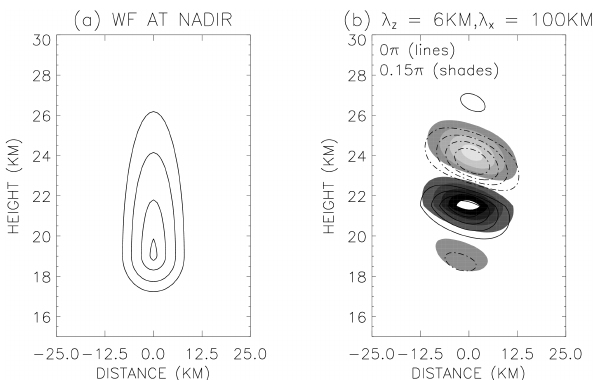
Fig. 12. Variance differences between unshifted wave and the wave shifted by 0 . 15 π for λ x =700 km calculation (a) , and the variance difference between nadir FOV and the outmost FOV (b) as func- tions of λ z . The AIRS observed values (7-pt smoothing window applied) are denoted by dash lines. See text for details.